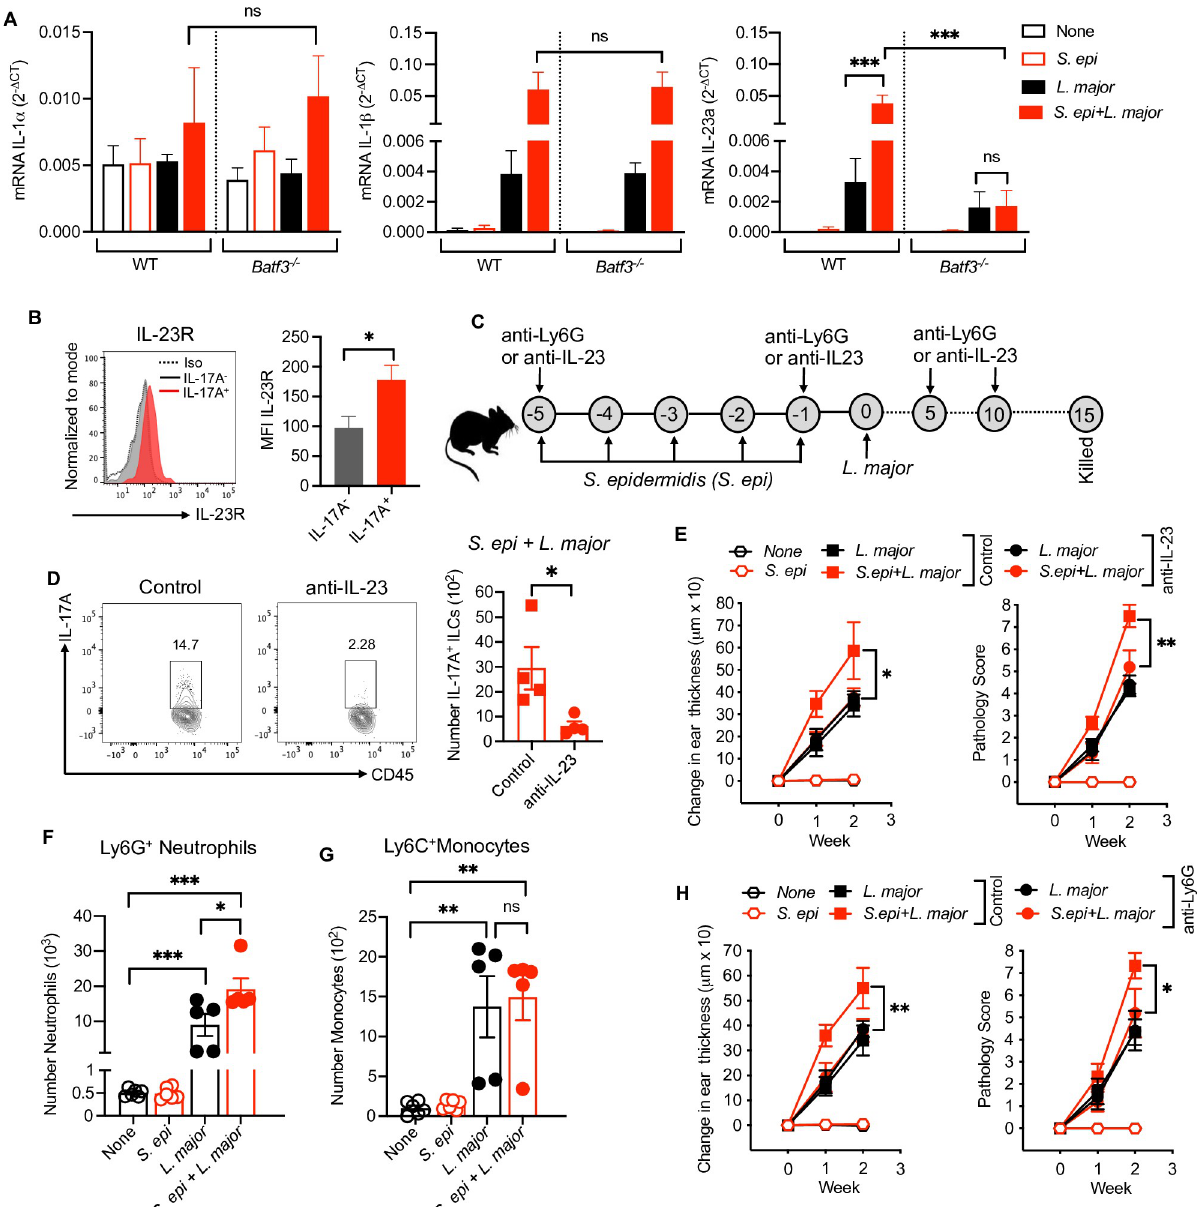
Fig 5. S . epidermidis dependent IL-17A + ILCs require IL-23. (A) qRT-PCR analysis of IL-1 α , IL-1 β and IL-23a in WT and Batf3 -/- mice in different treatment groups at week two. (B) IL-23R expression on IL-17A + and IL-17A - ILCs in S . epi colonized and L . major infected mice at week two. (C) Schematic representation of anti-IL-23 and anti-Ly6G treatment protocol in S . epi colonized and L . major infected WT mice. (D) IL-17A production from ILCs in control (IgG) and anti-IL-23 treated in S . epi colonized and L . major infected at week two. (E) Ear thickness measurement and pathology score in IgG and anti-IL-23 treated L . major and in S . epi colonized and L . major infected mice at week one and two. (F,G) Number of neutrophils and monocytes in different treatment groups at week two. (H) Ear thickness measurement and pathology score in IgG and anti-Ly6G treated L . major and in S . epi colonized and L . major infected mice at week one and two. Number within the flow plot show percent of IL-17A + cells within the gated box. Data are from one experiment with a total of three to five mice in each group (A,B,D,E,F,G,H) Error bars show SEM (A,D,F) or SD (E,H). Two-tailed unpaired Student’s t-test with Welch’s correction or one-way ANOVA with Tukey’s multiple comparison analysis (A,F,G). ns, not significant; � p < 0.05, �� p < 0.01, ��� p < 0.001.